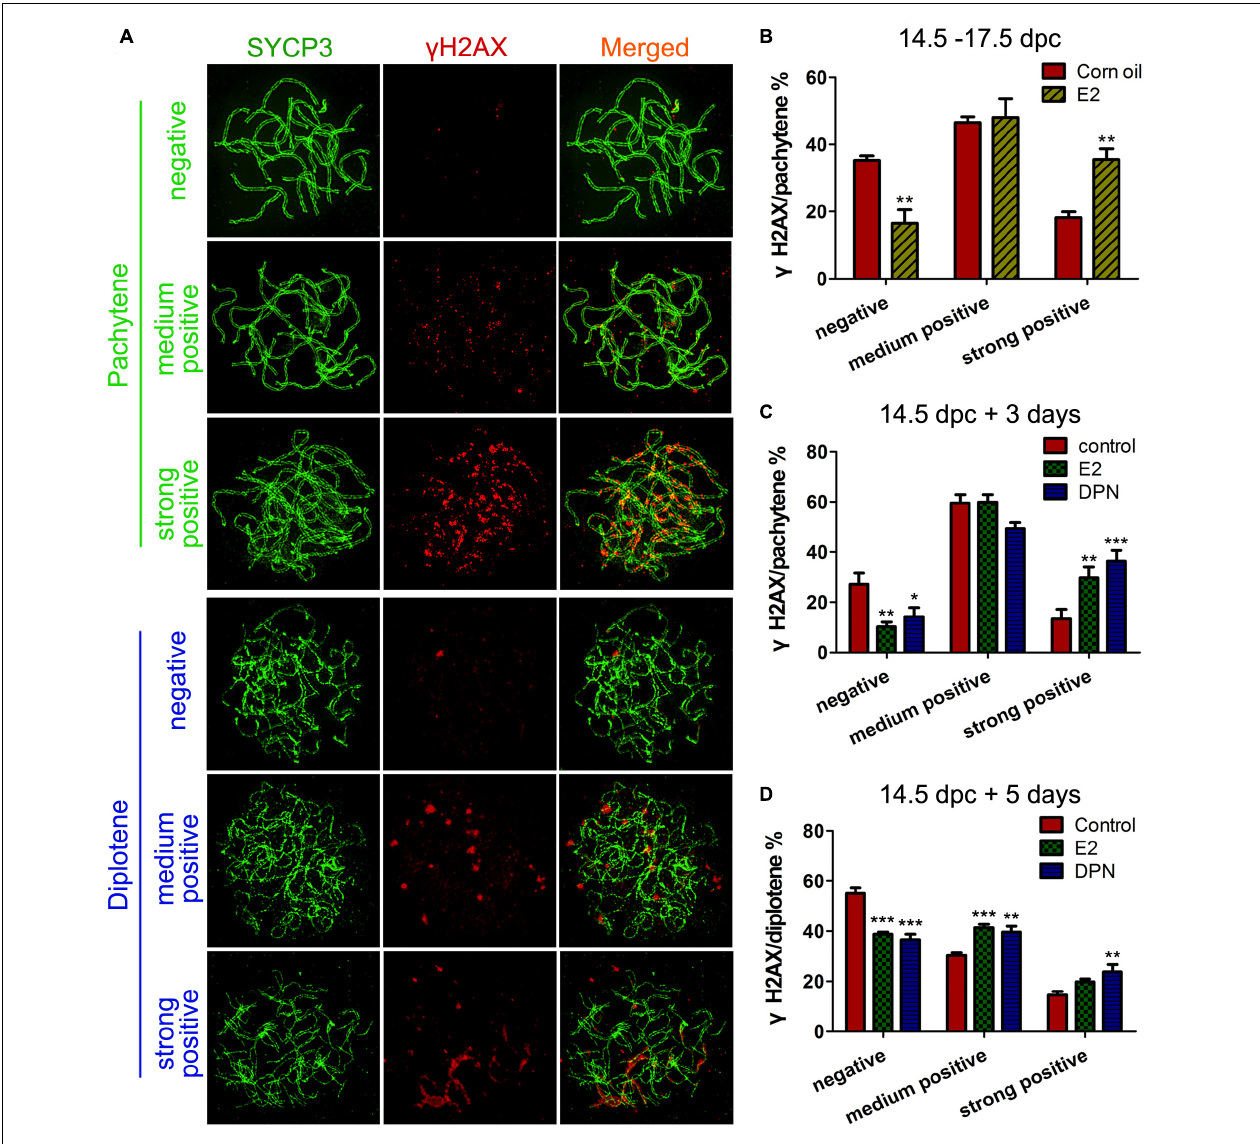
FIGURE 3 | E 2 Disrupts γ H2AX pattern in fetal oocytes. (A) Three classes of γ H2AX pattern in pachytene and diptotene oocytes. (B) The effect of In utero exposure of E 2 on γ H2AX patterns of pachytene oocytes. (C) The effect of E 2 and DPN on γ H2AX patterns of pachytene oocytes in ovary cultures. (D) The effect of E 2 and DPN on γ H2AX patterns of diplotene oocytes in ovary cultures. ** P < 0.01. *** P <